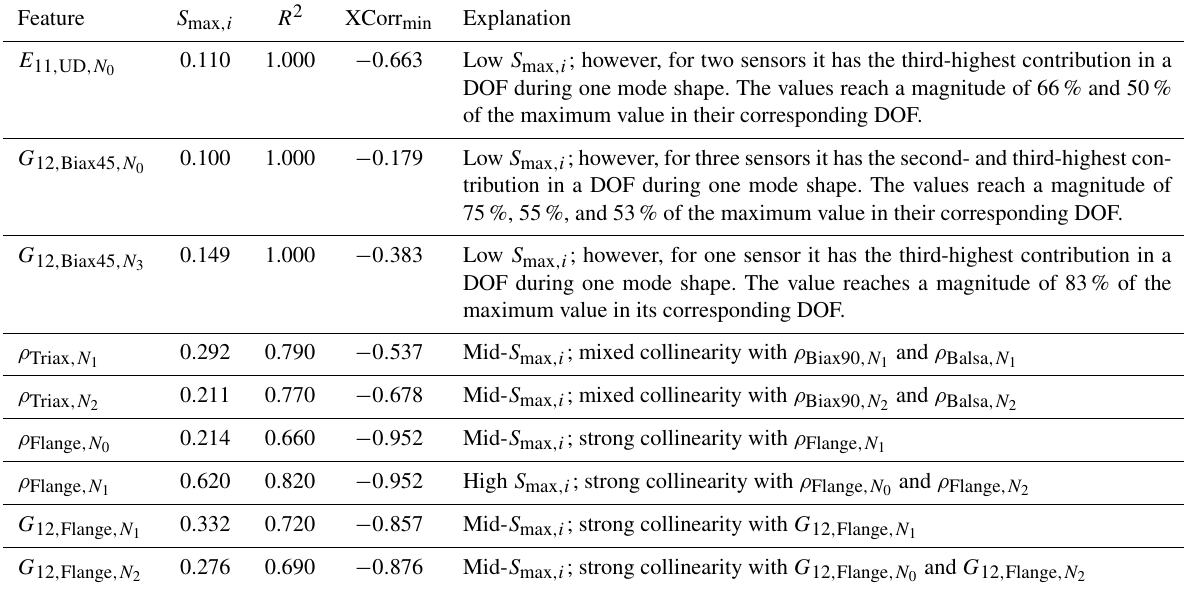
Figure 8. The two graphs show the standardized posterior prediction for all updated input features related to the target value with 1 σ standard deviation as error; thus the mean value marks the distance to the target value, i.e., ground truth. Table 4. Most striking discrepancies of the sensitivity and prediction accuracy of input